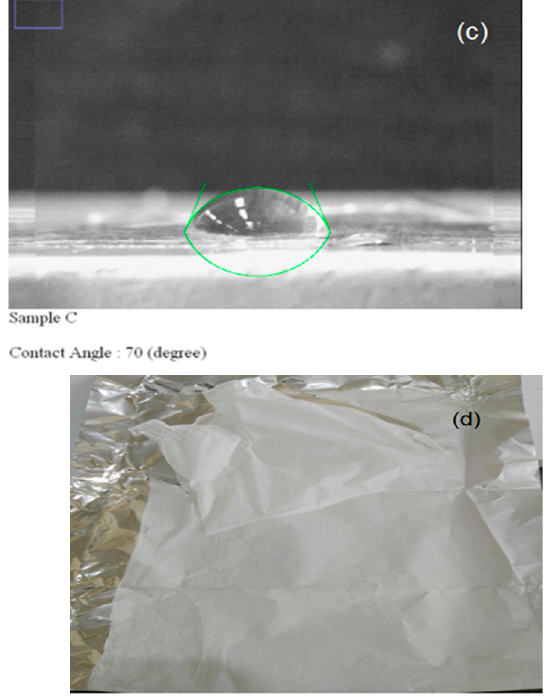
Figure 4. ( a ) SEM images, ( b ) fiber diameter distribution, ( c ) contact angle, ( d ) the image of Bup/PVP/PVA nanofiber.